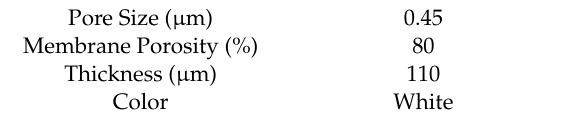
Table 1. Specifications of the polyvinylidene fluoride (PVDF) membrane.